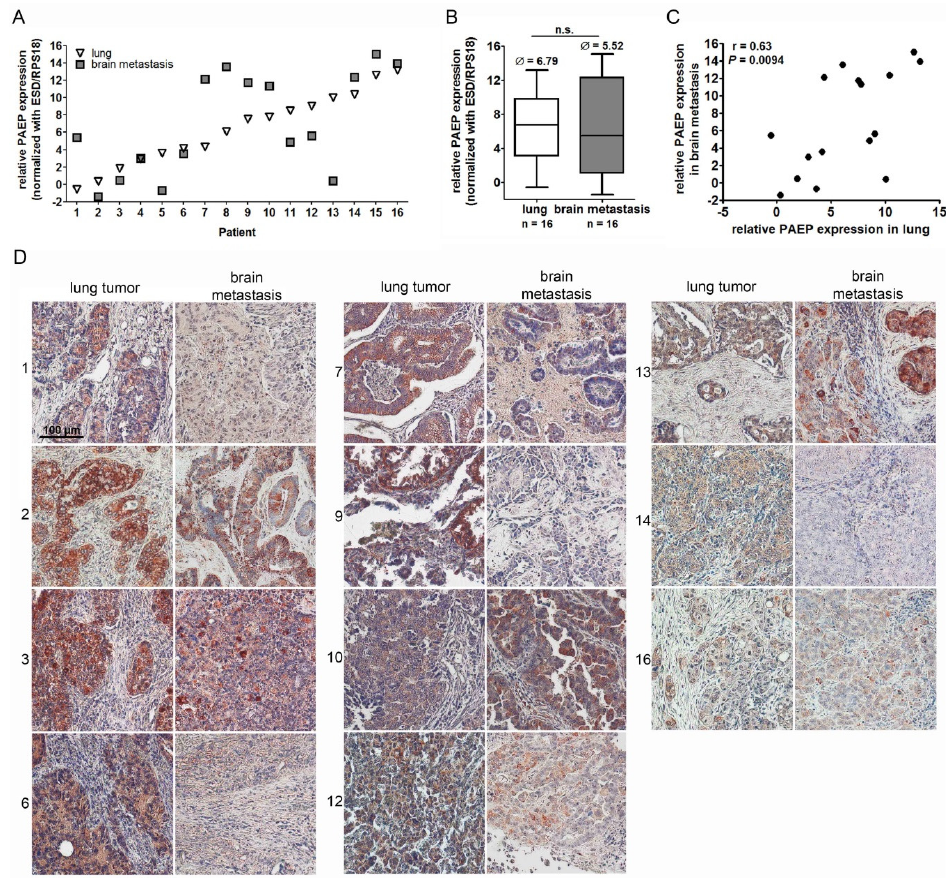
Figure 2. Glycodelin expression in primary tumors and brain metastases. 16 patient samples (primary lung tumors and brain metastases) were investigated for PAEP /glycodelin expression. ( A ) Relative PAEP gene expression ( ∆ Ct) in primary tumors and brain metastases. Please note that a lower value means a higher gene expression. ( B ) Median expression levels of PAEP in NSCLC tumors and brain metastases. Ø: median ( C ) Nonparametric correlation analyses of PAEP gene expression. ( D ) Immunohistochemical tumor staining of 12 patients from ( A ) with a glycodelin specific antibody (FFPE tissue was not available for the other five patients). A representative area is shown. p < 0.05 was considered as significant. n.s. = not significant, PAEP = progesterone-associated endometrial protein, NSCLC = non-small cell lung cancer.